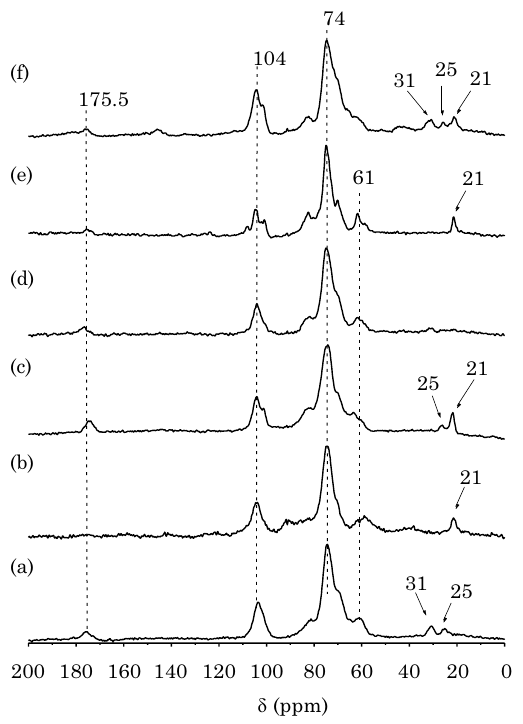
figure 3. 13 C nMr spectrum of the exopolysaccharides produced by: (a) Rhizobium giardini bv. giardini h152 t , (b) Mesorhizobium loti lMG6125, (c) Mesorhizobium plurifarium lMG11892, (d) Sinorhizobium (= Ensifer ) kostiense lMG19227, (e) Mesorhizobium huakuii lMG14107, and (f) Rhizobium mongolense